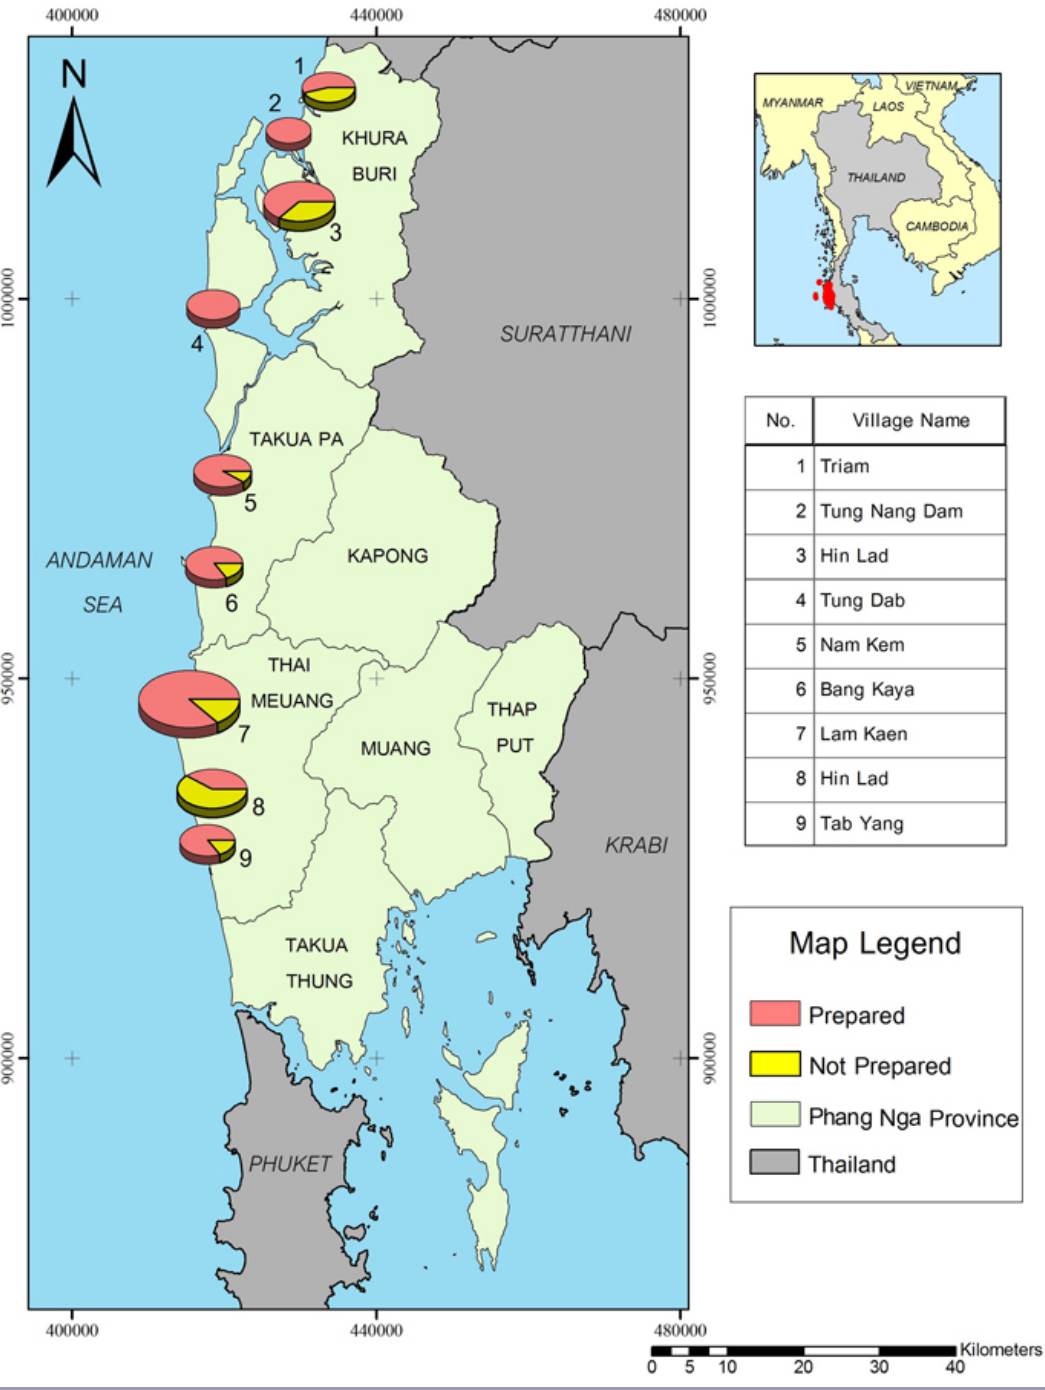
Fig. 1 . Map of sampled nine villages in Phang Nga province and percentage of respondents undertaking preparedness actions in a village (size of pie chart corresponds with population